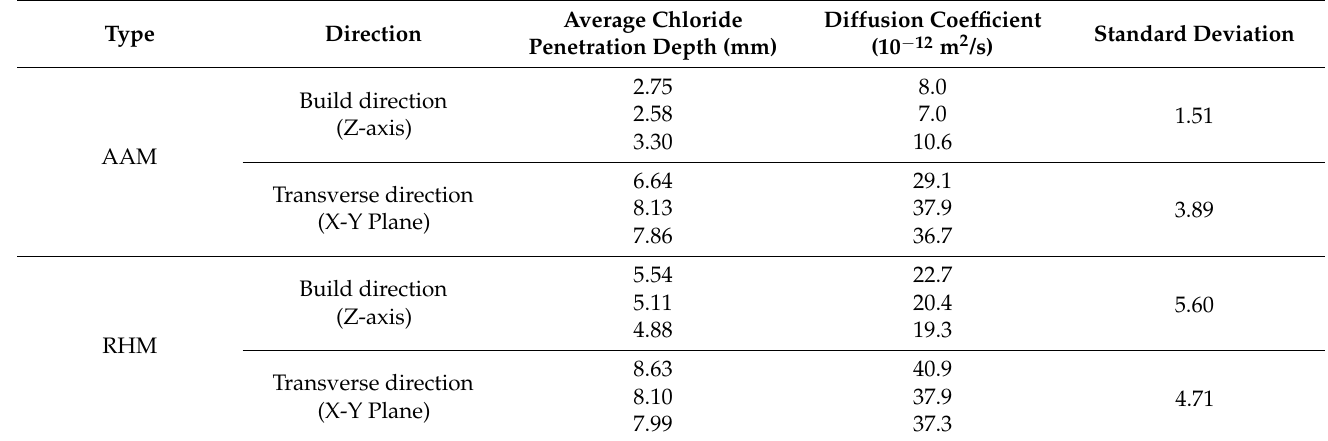
Table 4. Chloride diffusion coefficient depending on the BJ3DP material and the build orientation (alkali-activated mortar (AAM), rapid hardening mortar (RHM)).